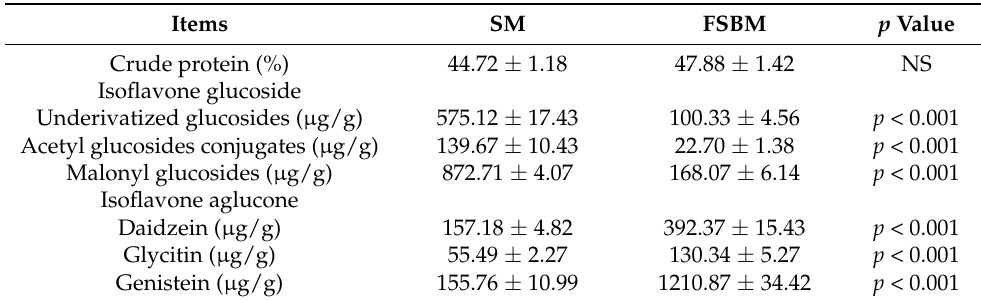
Table 1. Crude protein and soy isoflavone content of the soybean meal (SM) and fermented soybean meal (FSBM) used in the experimental diets. Items SM FSBM p Value Crude protein (%) 44.72 ± 1.18